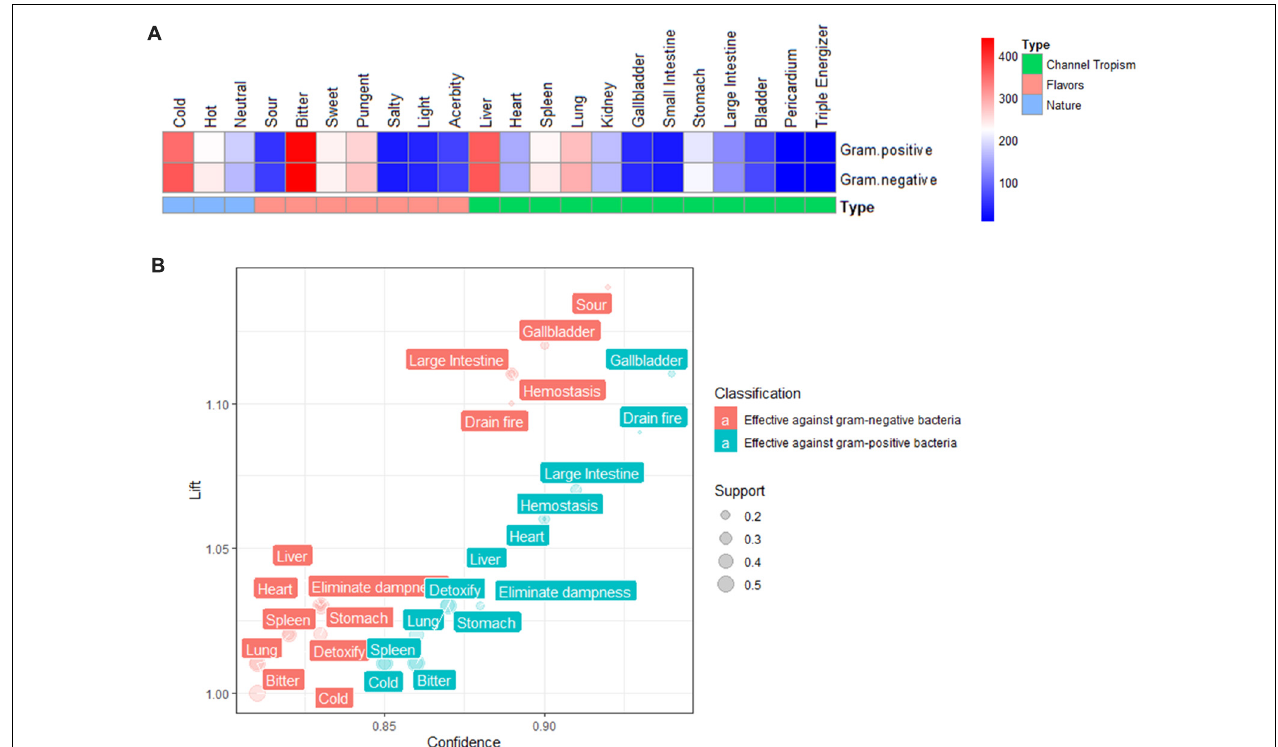
FIGURE 3 | Distribution law of antibacterial TCMs properties. (A) Heatmap of antibacterial TCMs properties frequency. (B) Comparison results of association rules for the properties of TCM against gram-positive bacteria and gram-negative bacteria. Cold is the medicinal nature; bitter and sour are the medicinal tastes; the liver, heart, spleen, lung, gallbladder, stomach, and large intestine are the meridians tropism; hemostasis, drain fire, eliminate dampness, and detoxify are medicinal efficacies.